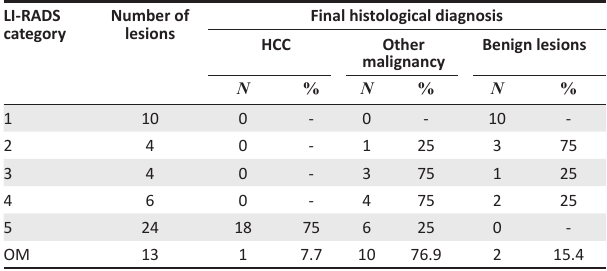
LI-RADS, Liver Imaging Reporting and Data System; HCC, hepatocellular carcinoma; OM, other TABLE 3: Diagnostic performance of hepatocellular carcinoma diagnosis using Liver Imaging Reporting and Data System 4 and 5 categories. Diagnostic criteria Number of nodules Diagnostic performance ( % )